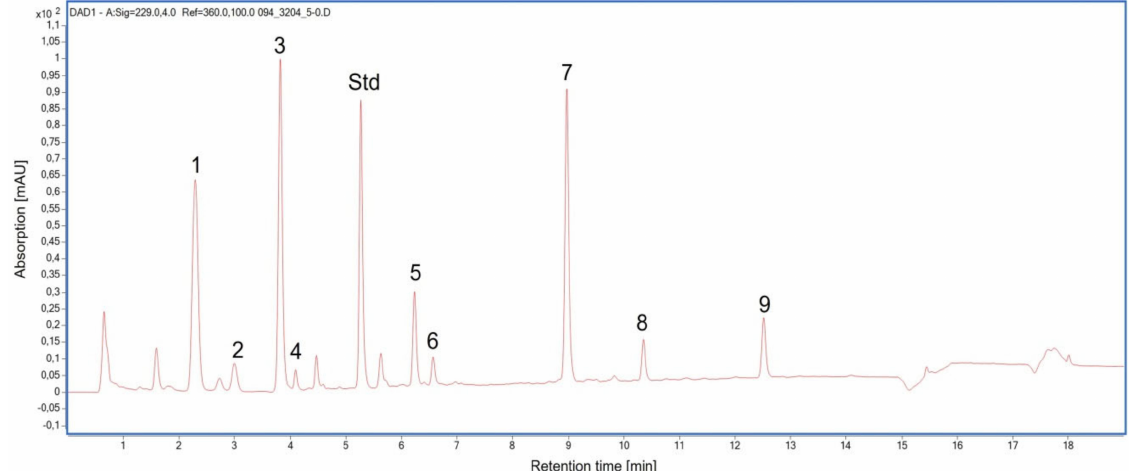
Figure 1. Chromatogram at 229 nm of the glucosinolate analysis of a cauliflower floret. Std, internal standard; 1, 3-methylsulfinylpropyl glucosinolate; 2, ( R )2-hydroxy-3-butenyl glucosinolate; 3, 2-propenyl glucosinolate; 4, 4- methylsulfinylbutyl glucosinolate; 5, 4-hydroxyindol-3-ylmethyl glucosinolate; 6, 3-methylthiopropyl glucosinolate; 7, indol-3-ylmethyl glucosinolate; 8, 4-methoxyindol-3-ylmethyl glucosinolate; 9, 1-methoxyindol-3-ylmethyl